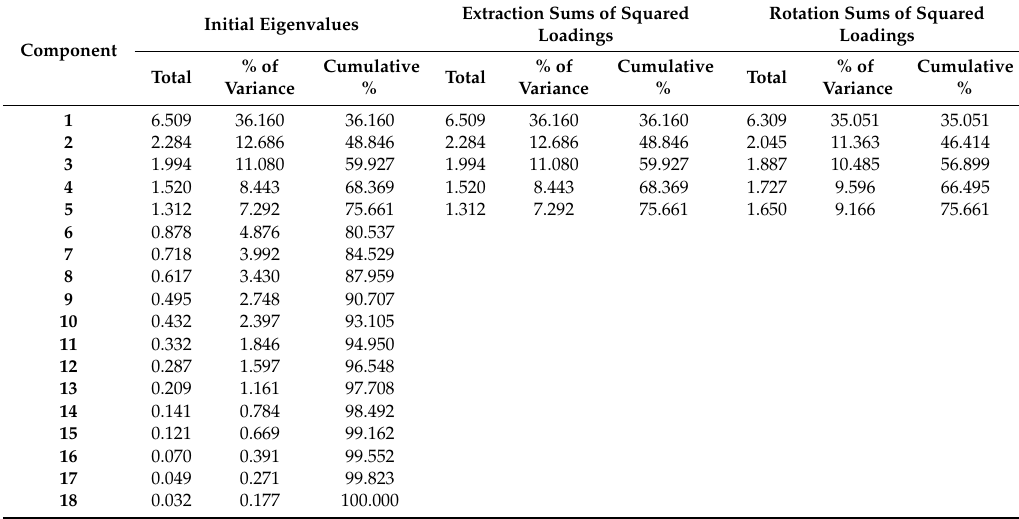
Table 3. Total variance